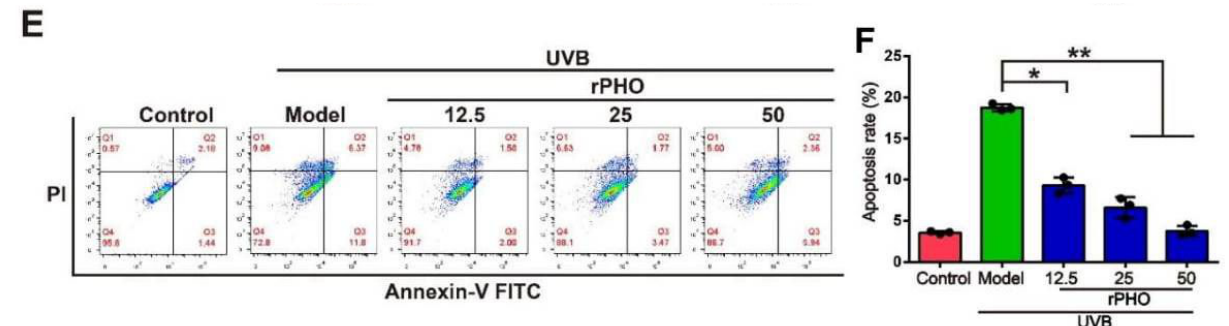
Figure 9. Photolyase inhibited UVB-induced apoptosis in HaCaT cells. ( A ) Release of cytochrome c in HaCaT cells treated with rPHO by immunofluorescence staining. Cytochrome c and nuclei are indicated by green and blue fluorescence, respectively. Scale bars = 100 µ m. ( B ) Expression of caspase 3, Bcl-2, and Bax in HaCaT cells examined by western blotting. ( C , D ) Statistical analysis of protein expression in ( B ). ( E ) Apoptosis was measured by flow cytometry. ( F ) Statistical analysis of the apoptosis rates. Data are presented as means ± SD ( n = 3). * p < 0.05, ** p <